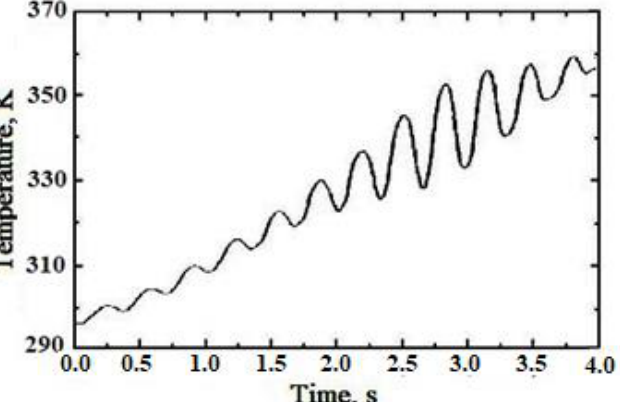
Figure 6. The dependence of the temperature of the sample on time during gradual heating under the influence of external periodic mechanical stress with a frequency of 3 Hz, with a maximum value of 300 MPa.